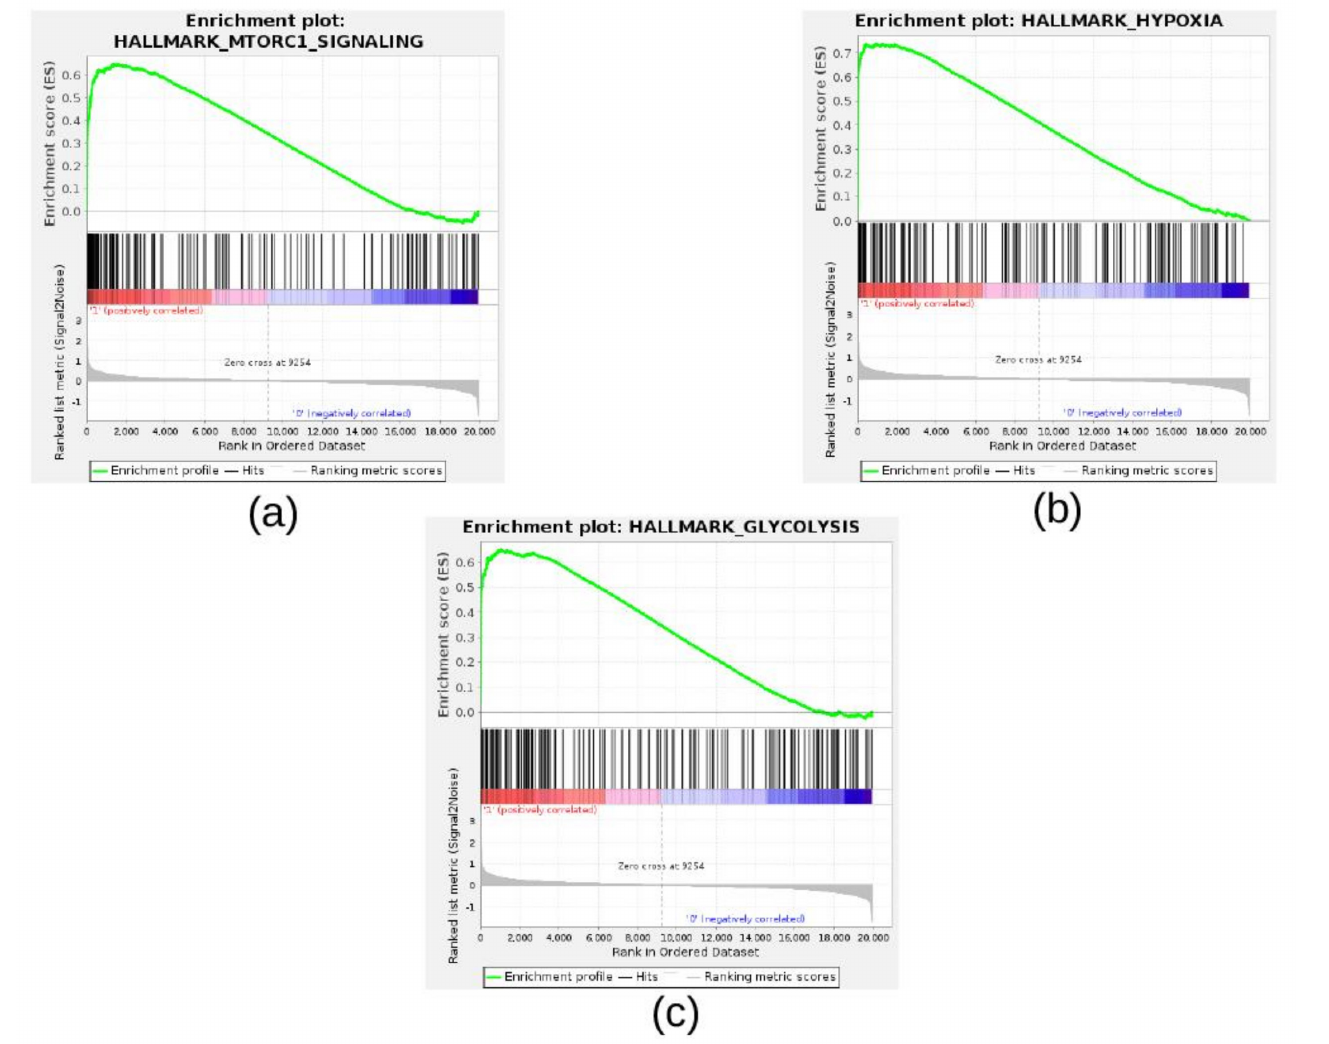
Figure 7. Enrichment plots for selected hallmark gene sets found positively enriched in SK-N-BE(2)c cells cultured under hypoxia and treated with DMSO with respect to SK-N-BE(2)c cells cultured under normoxic conditions. The enrichment plot shows the gene set name (top), the running enrichment score (green curve), the positions of the gene set hits on the rank ordered list in GSEA (black bars), and the rank ordered list according to the signal-to-noise metric (bottom). Red indicates the highest signal-to-noise values, whereas blue indicates the lowest ones. Plots are relative to ( a ) HALLMARK_MTORC1_SIGNALING, ( b ) HALLMARK_HYPOXIA, and ( c )